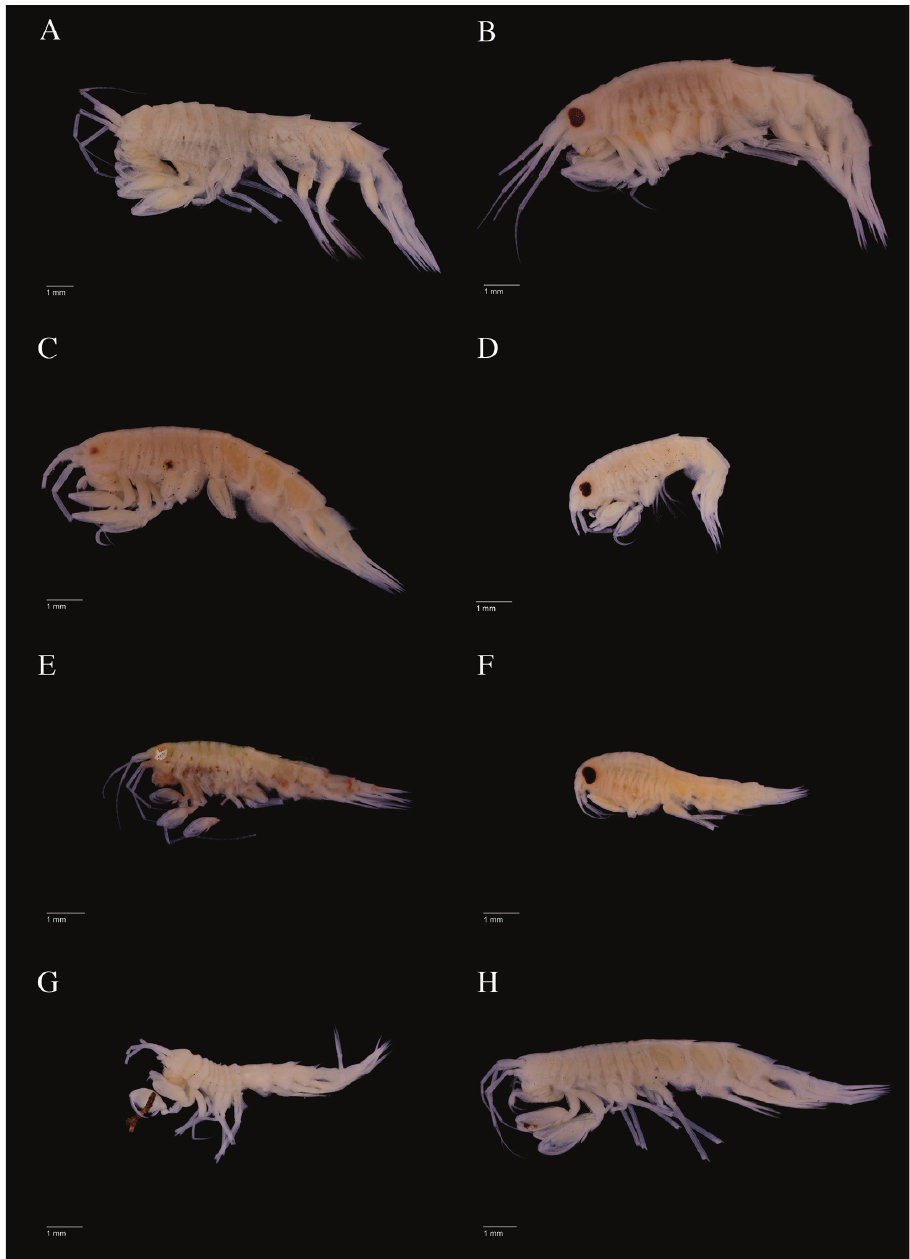
Figure 4. Lateral view photos of IceAGE material representing different clades in the analyses. A Rha- chotropis gislii AMPIV004-17 B R. helleri AMPIV233-17 C R. aff. helleri AMPIV011-17 D R. inflata AMPIV070-17 E R. northriana AMPIV225-17 F R. oculata AMPIV228-17 G R. aff. palporum AM- PIV033-17 H R. aff. proxima AMPIV005-17 I R. cf. proxima AMPIV002-17 J R. sp. B AMPIV009-17 K R. thordisae AMPIV007-17 L R: thorkelli